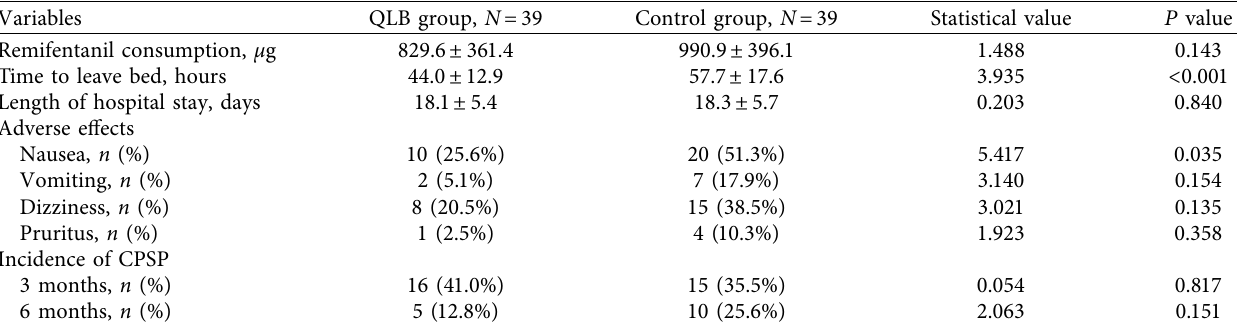
Table 4: Outcome measurements of the